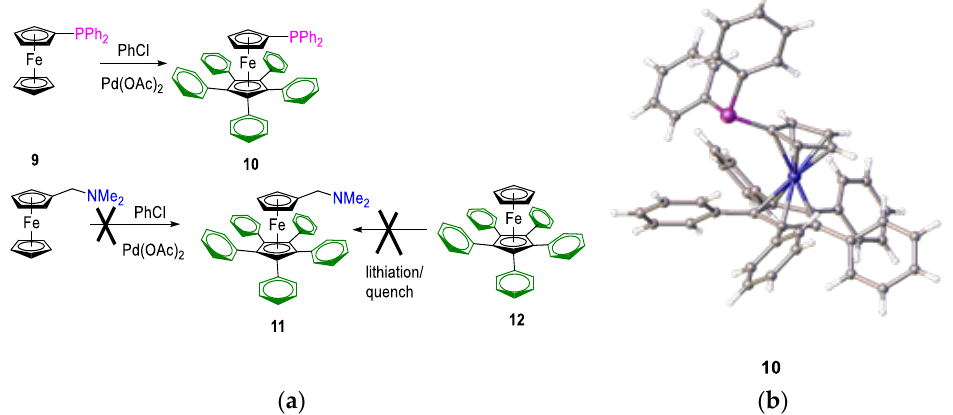
Figure 9. ( a ) Preparation of per-aryl-substituted ferrocenylphosphine 10 , from diphenylphosphinoferrocene 9 , and the scheme showing the difficulty of preparing analogous ferrocenylethylamine, 11 , from either N,N-dimethylaminomethylferrocene or compound 12 using n-BuLi lithiation followed by quenching with Eschenmoser’s salt. ( b ) crystal structure of compound 10 .